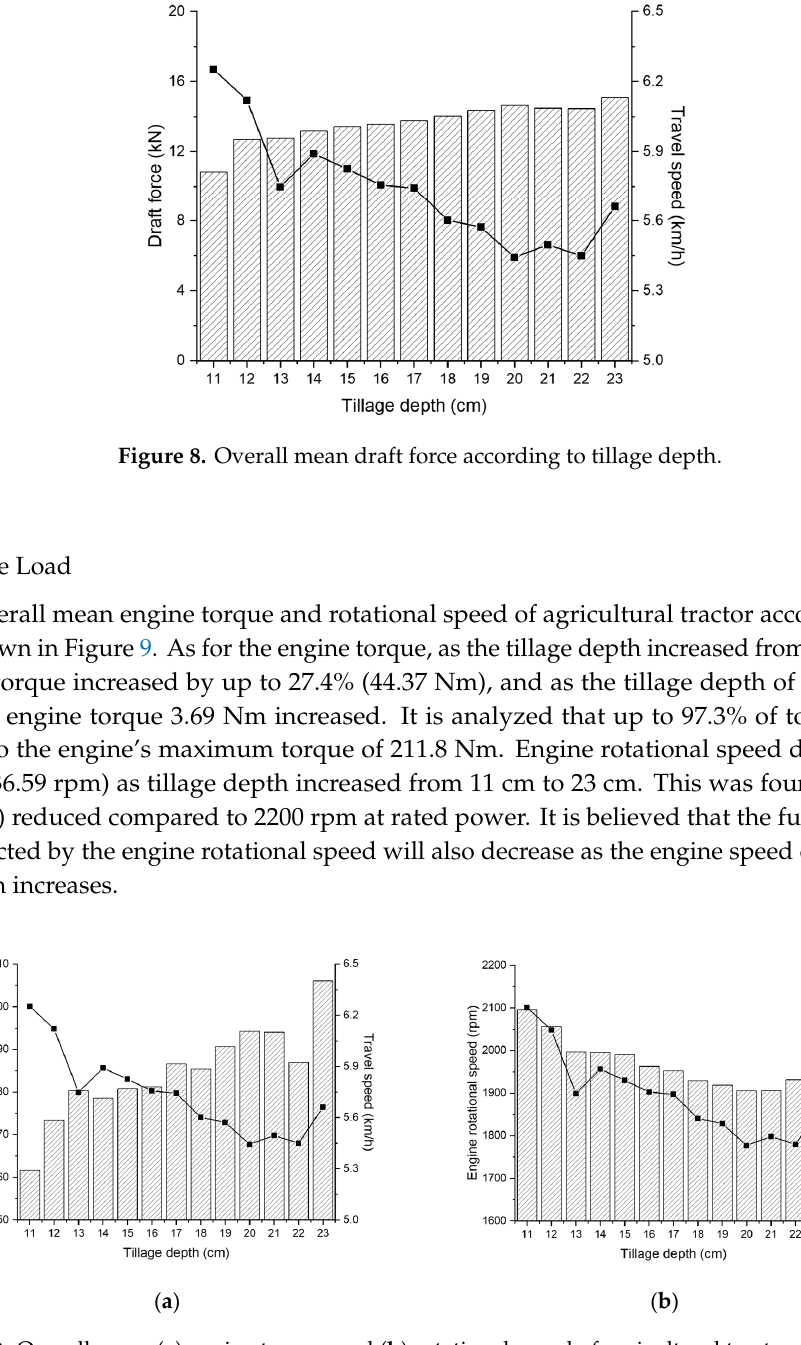
Figure 7. Overall mean ( a ) travel speed, and ( b ) slip ratio of agricultural tractor according to tillage depth during moldboard plowing.